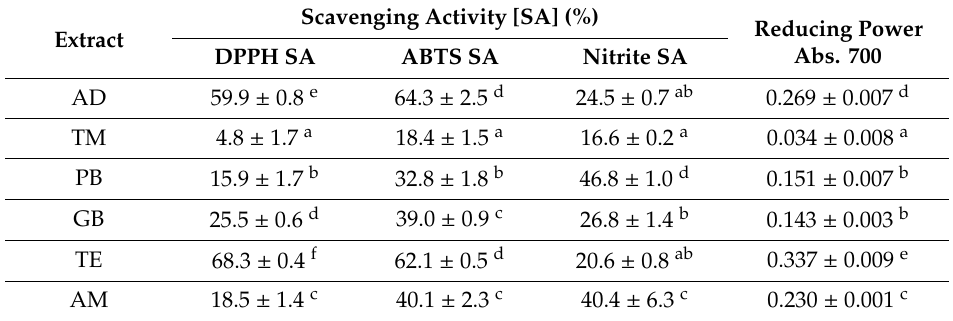
Table 6. Anti-oxidant activities of the ethanol extracts of 6 di ff erent insect species. Scavenging Activity [SA] Extract